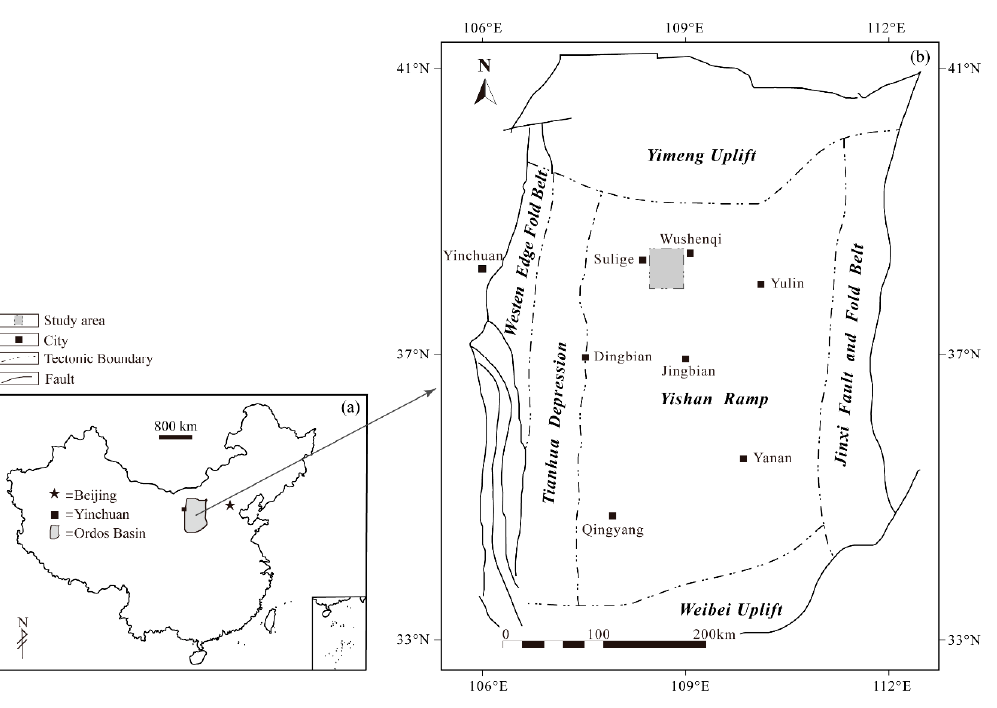
Figure 1. Location of the study area showing in the tectonic map of Ordos Basin. ( a ) Geographic location of the Ordos Basin; ( b ) geographic location of the study area.